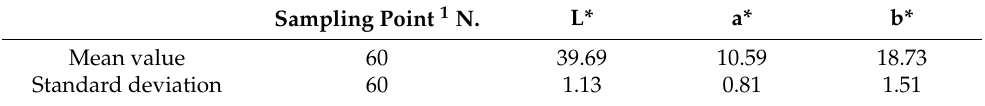
Table 3. Lightness and colorimetric parameters in CIELAB colour space.